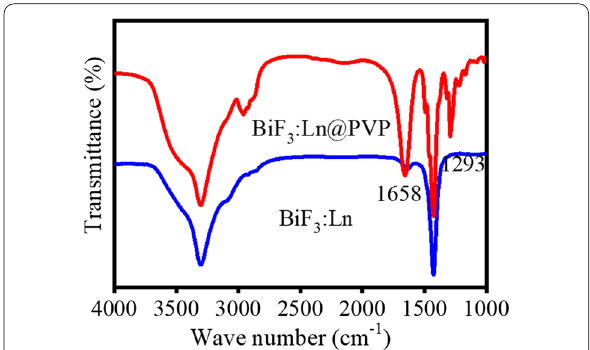
Fig. 2 FTIR spectra of BiF 3: Ln@PVP NPs. The blue line represents the initial absorption peak of the BiF 3 : Ln. The red line represents the absorption peak after modifying PVP to the surface of nanoparticles